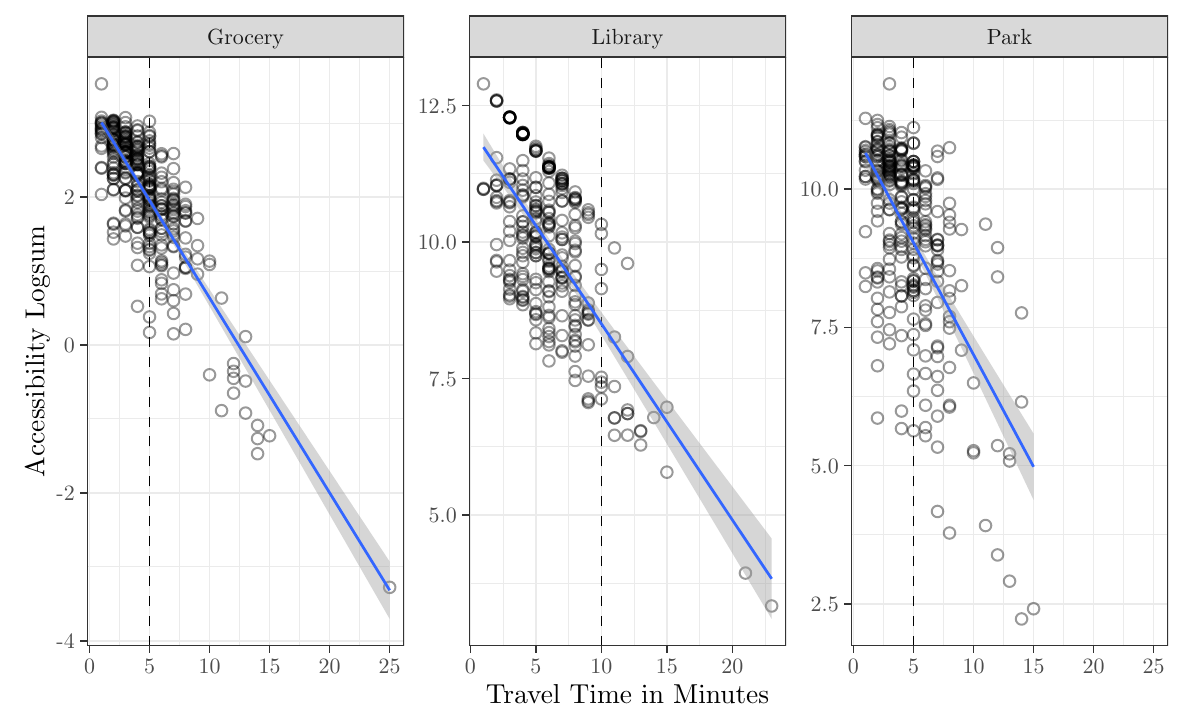
Figure 4. Relationship between travel time and logsum access value for block groups in Utah County. Travel time thresholds shown as dashed lines, with best fit regresssion line added for